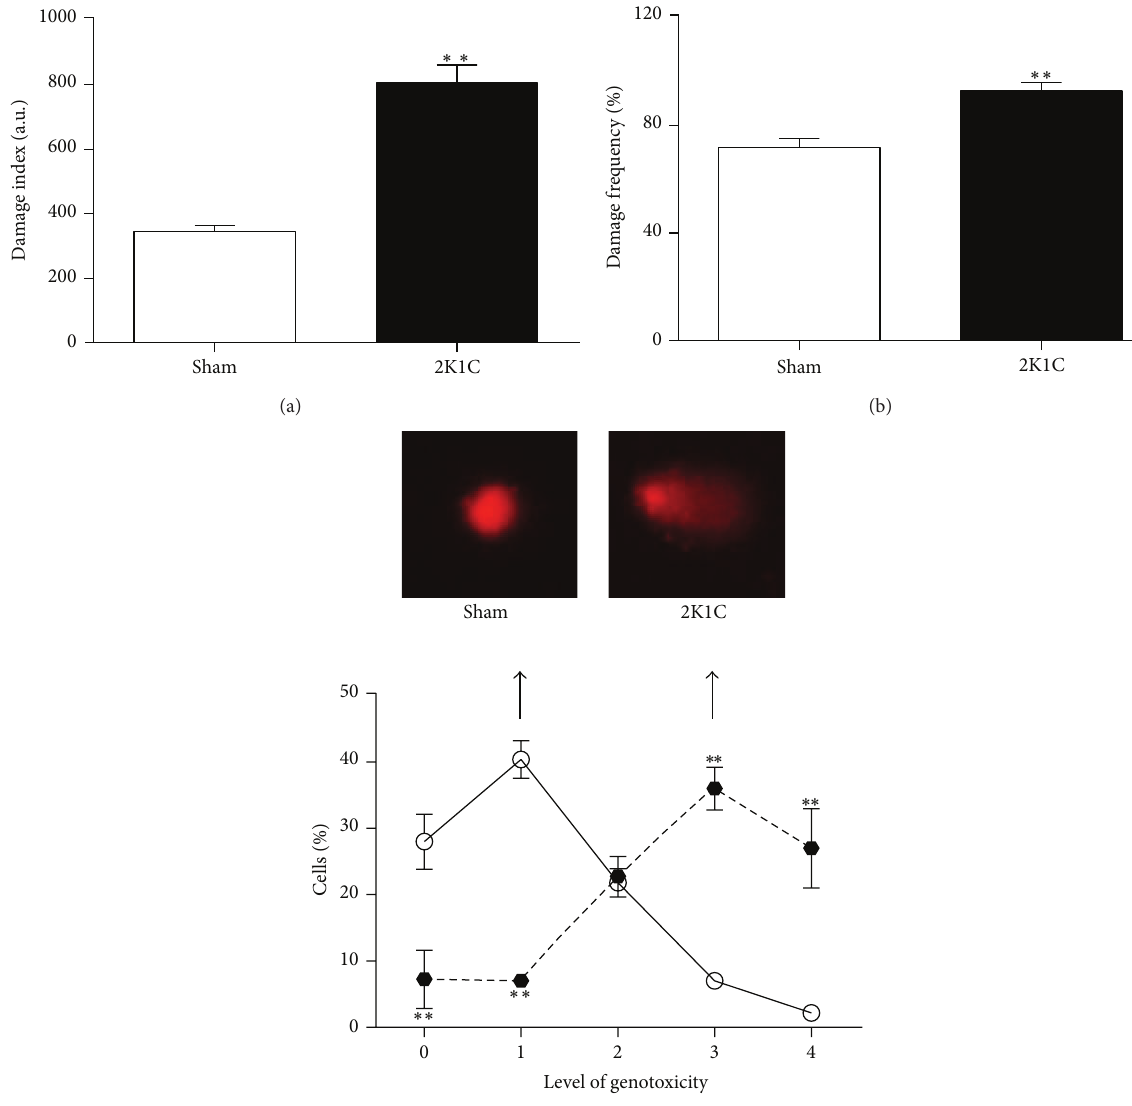
Figure 3: Bone marrow mononuclear cell DNA damage assessed by the comet assay. The left bar graphs demonstrate the average DNA damage index (a) and frequency (b). ∗∗ 𝑃 < 0.01 versus the Sham group (Student’s 𝑡 test for independent samples). Fluorescent images (c) are typical comets demonstrating increased DNA fragmentation in a renovascular hypertensive (2K1C) mouse compared with a normotensive (Sham) mouse. The lines graph (c) demonstrates the average percentages of DNA damage percentages for each genotoxicity level, comparing the 2K1C (filled circles, 𝑛 = 5 ) with the Sham (empty circles, 𝑛 = 6 ) mice. ∗∗ 𝑃 < 0.01 versus the Sham group (two-way Anova). Values are the means ±